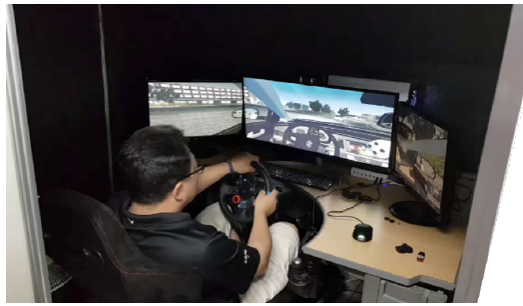
Figure 7. A participant driving in the driving simulator.